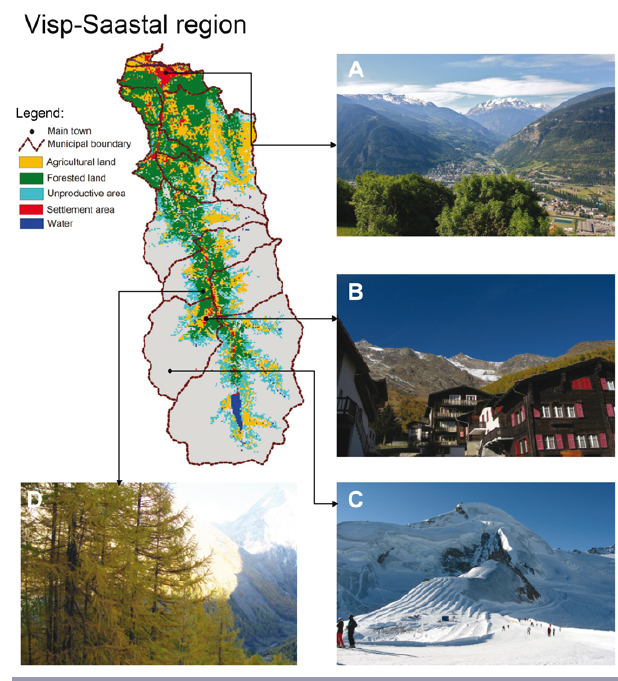
Fig. 3 . Design of our scenario study combining the global/ national and the local levels by means of an external consistency analysis to arrive at joint